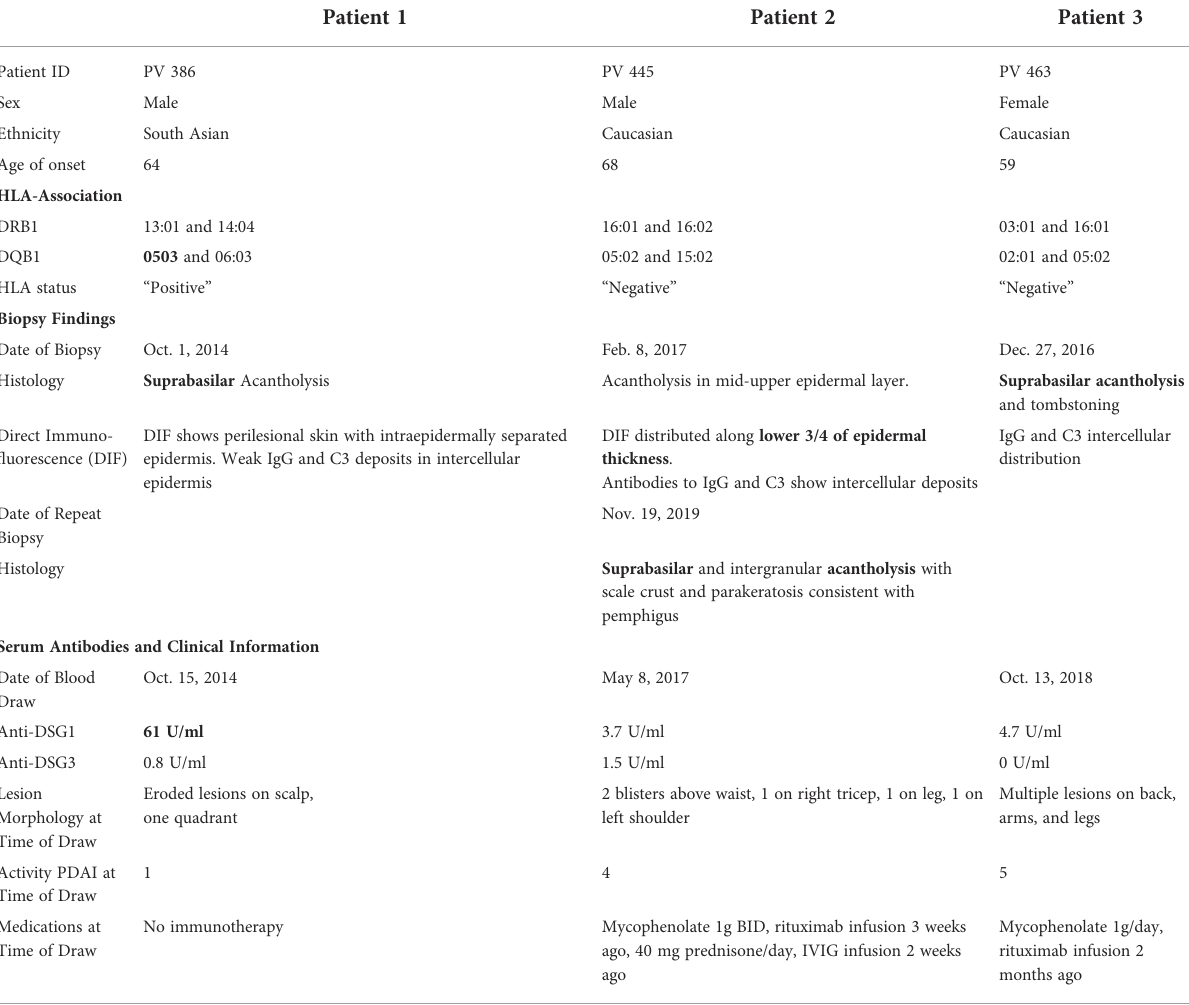
TABLE 1 Patient Demographics and Clinical